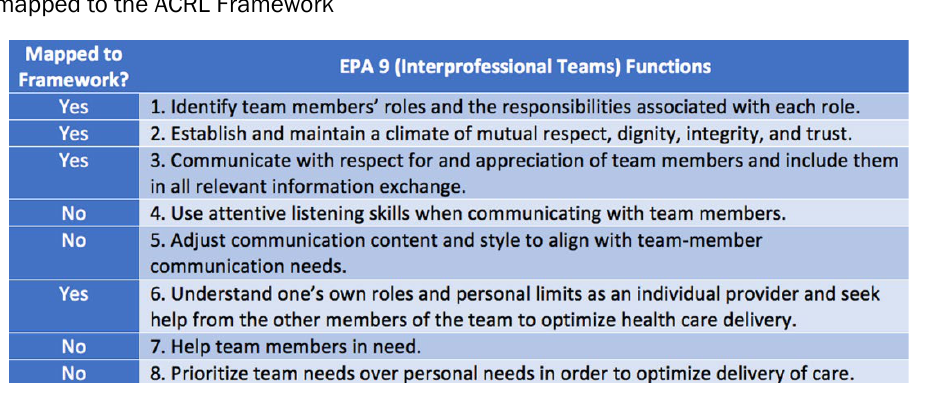
Figure 2 EPA 9 mapped to the ACRL Framework